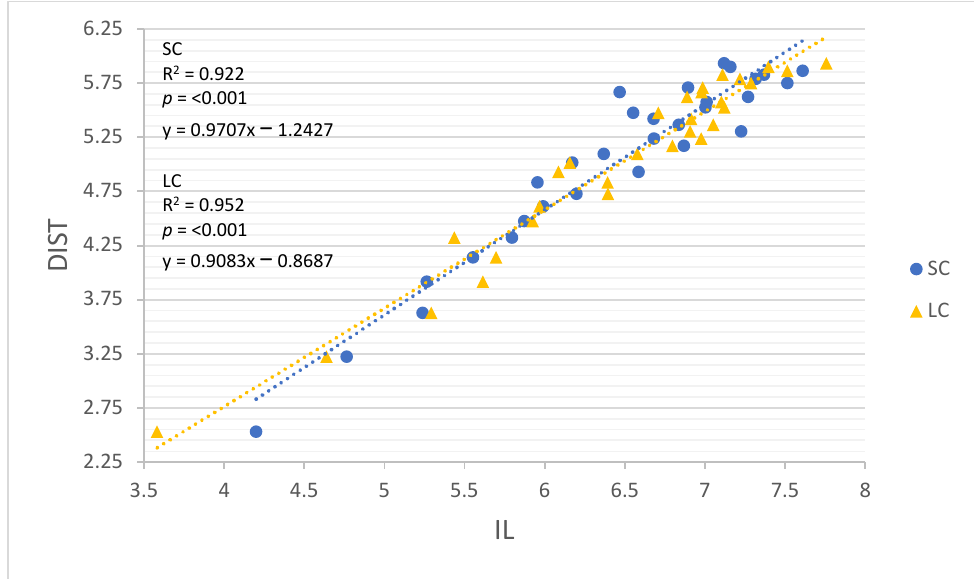
Figure 3. The relationship between log transformed DIST and IL around the small circle and the large circle. SC = small circle, LC = large circle.